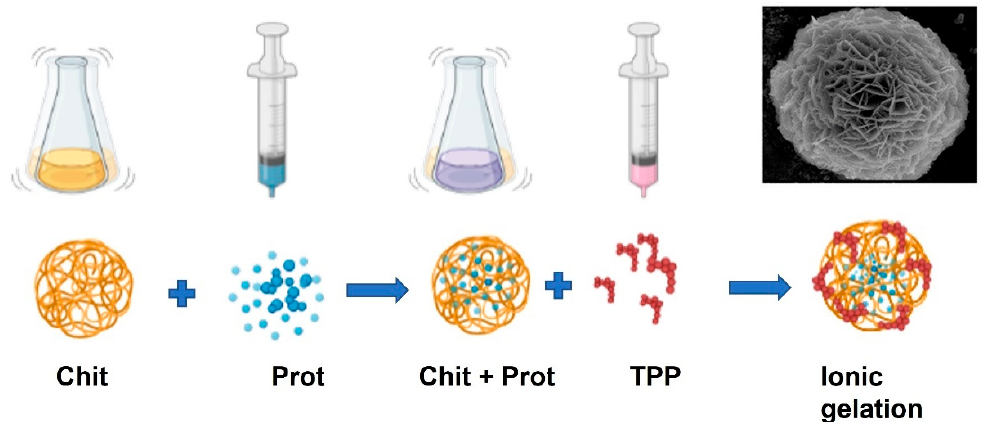
Figure 2. Schematic illustration of the preparation procedure for protein chitosan immobilization. Protein-loaded chitosan beads can be prepared by an ionic gelation technique. Chitosan (Chit) is firstly mixed with protein (Prot) to provide a homogeneous solution (Chit + Prot). Then interacts with sodium tripolyphosphate (TPP) solution to allow the protein to be encapsulated during the ionic gelation process.